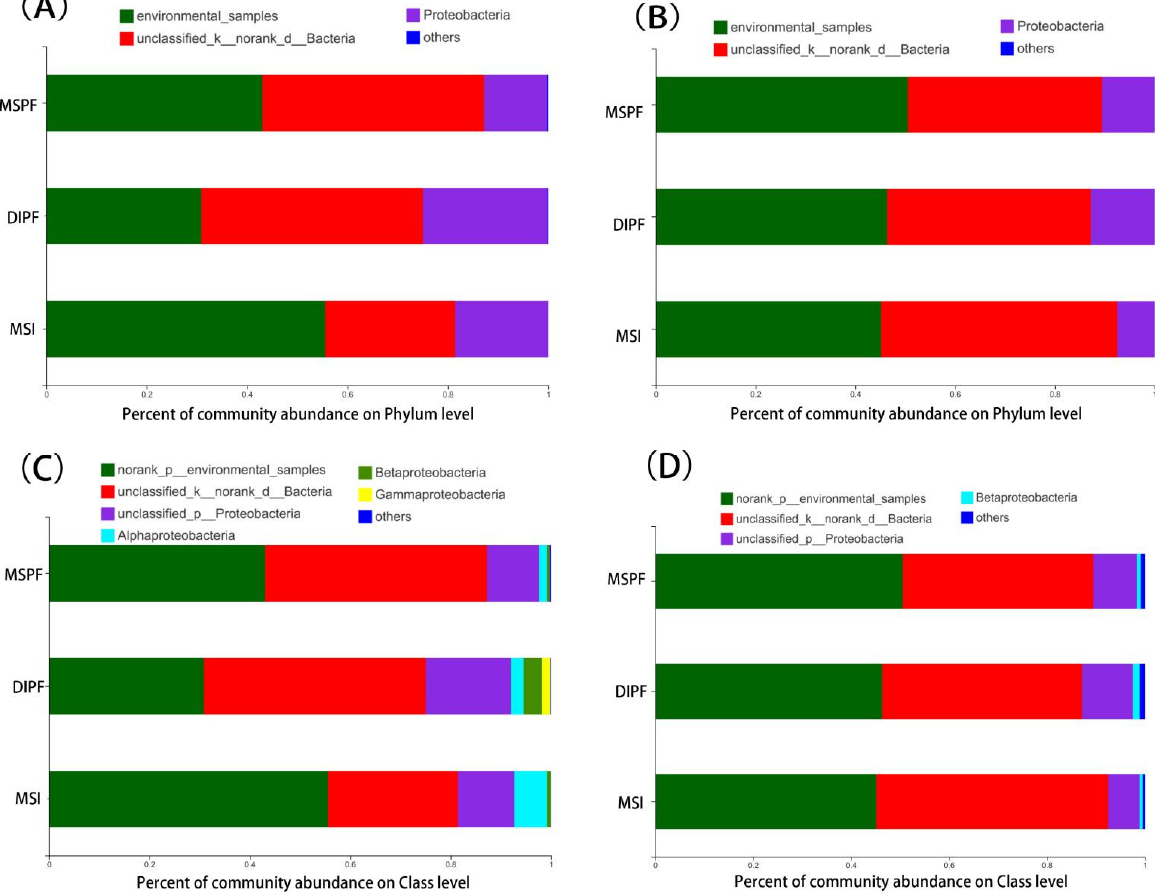
Figure 8. Microbial structure composition of nirS -type denitrifying bacteria under different irriga- tion treatments. Note: ( A ) community structure at the phylum level during spring; ( B ) community structure at the phylum level during autumn; ( C ) community structure at the Class level during spring; ( D ) community structure at the Class level during autumn.